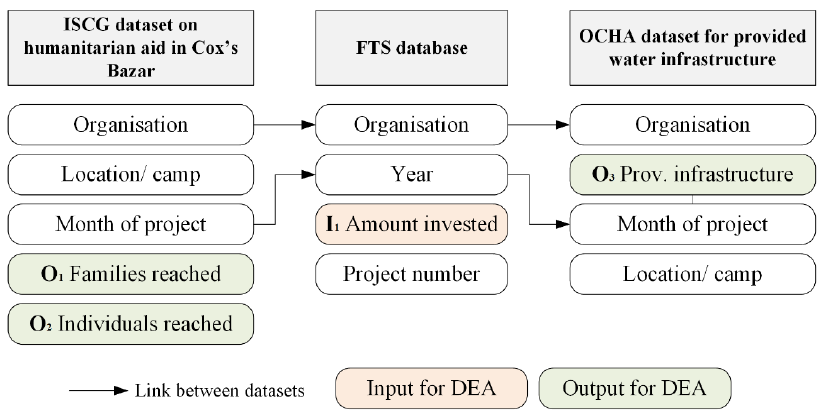
Figure 2. Data sources and data envelopment (DEA) model for the analysis of NPO/non-government organizations (NGO). Note: ISCG (Inter Sector Coordination Group) [60], FTS (Financial Tracking Service), OCHA (United Nations Office for the Coordination of Humanitarian Affairs), I (inputs for DEA model), O (outputs for DEA model).